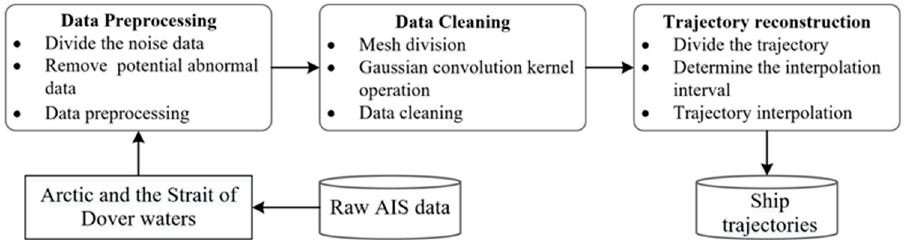
Figure 5. The flowchart of experiments.